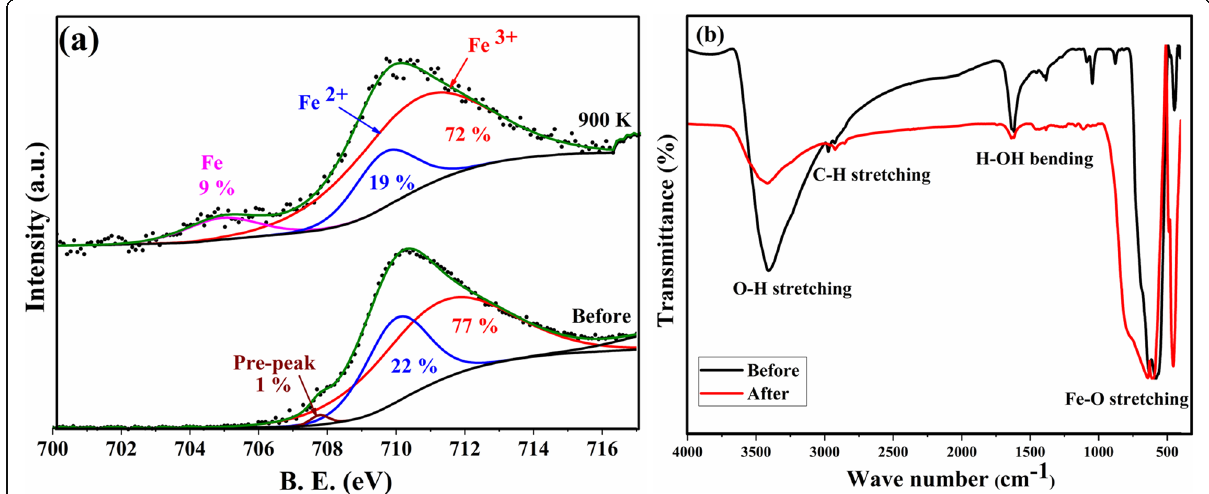
Fig. 5 a Deconvoluted high-resolution XPS spectra of Fe 2p 3/2 recorded from pristine Fe 3 O 4 sample before and after heating to 900 K (red, Fe 3+ ; blue, Fe 2+ ; magenta, Fe metallic tail). b FTIR spectra (transmission vs. wavenumbers) of Fe 3 O 4 nanoparticles before and after heating to 900 K